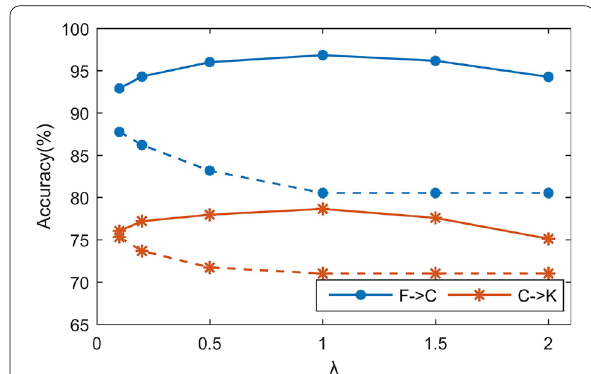
Figure 6 Classification accuracy of ML-ANet in MLIC tasks with respect to the parameter λ (The dashed lines show the results of